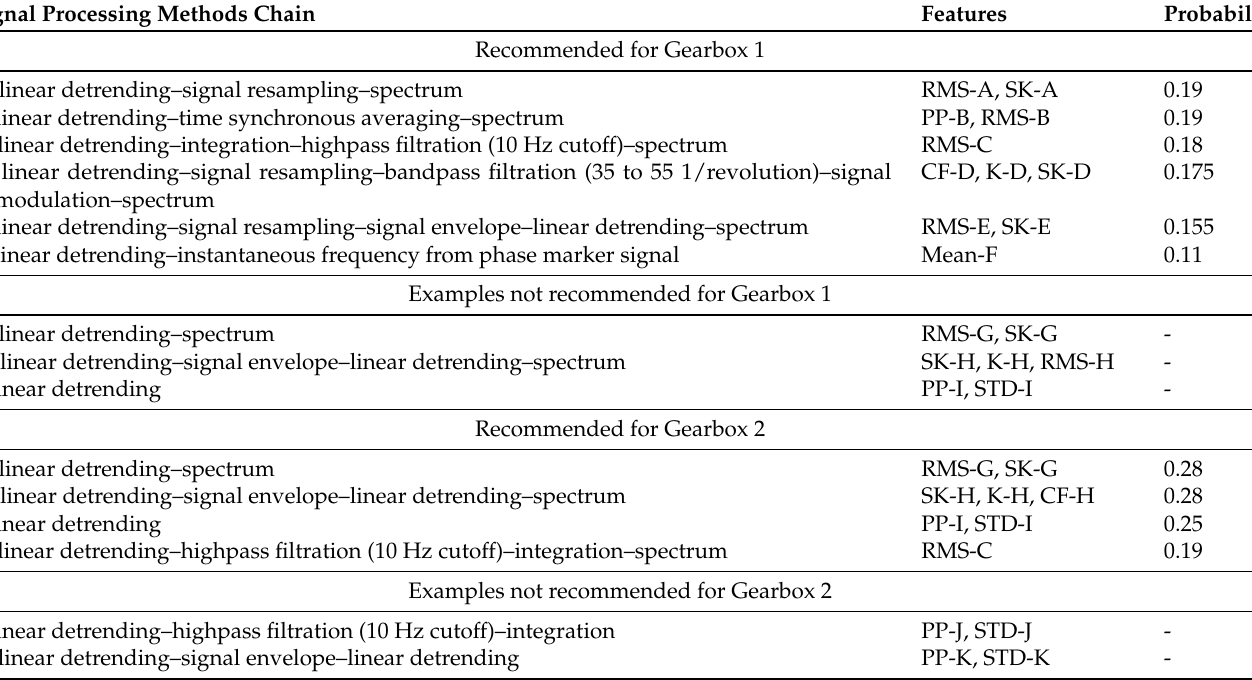
Table 5. Signal processing methods and features recommended for Gearbox 1 and Gearbox